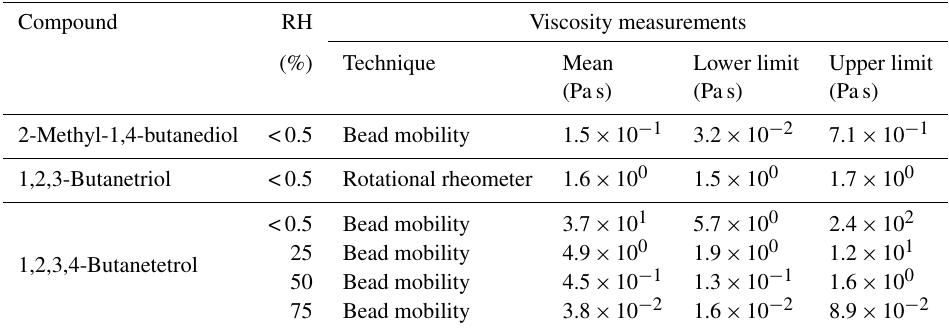
Table 4. Measured viscosities for the polyols and polyol–water mixtures studied here. The error associated with the rotational rheometer was not available, and so an error of 5% has been used, greater than the stated error of 0.1% reported for a similar rotational rheometer (Viscotester 550, Haake, Austria). For experiments using the bead mobility technique, the mean is reported along with lower and upper limits, which correspond to an uncertainty of 2 σ . Compound RH Viscosity measurements (%) Technique Mean Lower limit